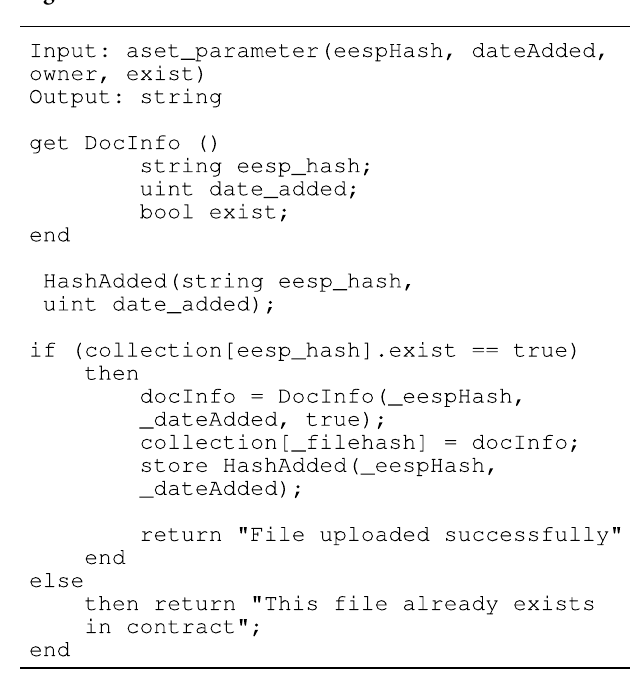
Algorithm 1. Store File to Blockchain